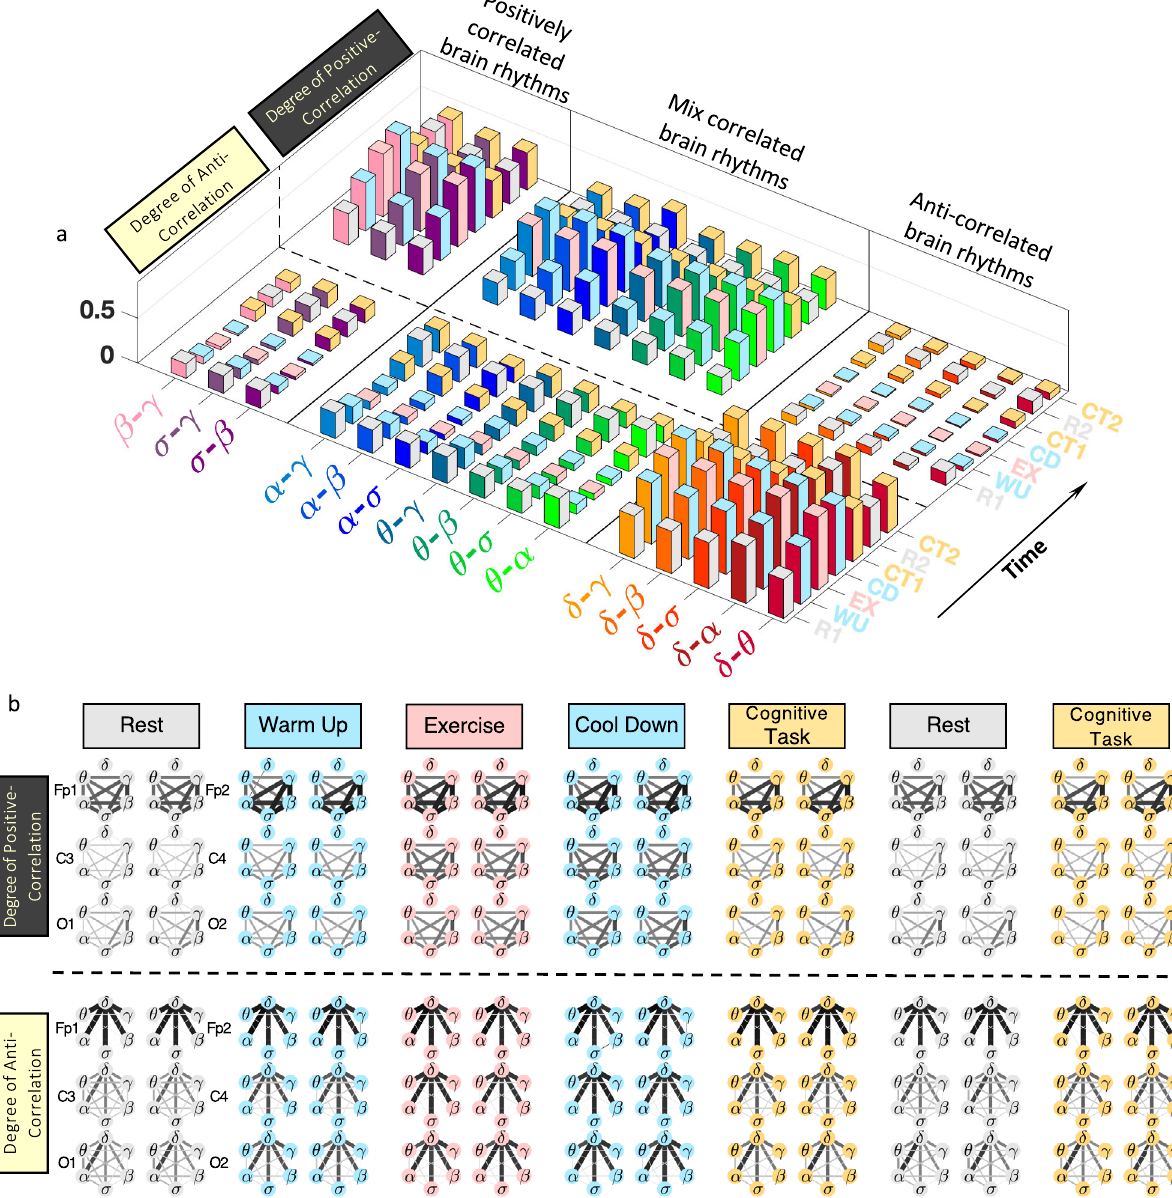
Fig. 5 Network communications and topological clustering of brain-rhythm interactions at different cortical locations uniquely represent physiological states. a Three-dimensional representation of the degree of positive and anti-correlated components of coupling (bars height shows coupling strength for positive ( D + ) and anti-correlated ( D − ) coupling, Methods) for the three major classes of brain-rhythm interactions (positively correlated, mix correlated and anti-correlated pairs of brain rhythms; Fig. 2), and their evolution in time (Experimental protocol, Methods) across physiological states. The panel shows coupling for all pairs of brain rhythms at the C3 EEG channel location and provides a complete picture of the response in brain-rhythm interactions to changes in physiological states. b Networks representing brain-rhythm interactions at six cortical locations (Fp1, Fp2, C3, C4, O1, O2) for the left- and the right-brain hemispheres during different physiological states. Sub-networks of positive (top panel) and anti-correlated (bottom panel) components of brain rhythms coupling exhibit variations in topology and links strength organization depending on cortical locations and physiological states. Line thickness and darkness are scaled linearly to link strength. A clear symmetry in network structure is observed between the left (Fp1, C3, O1) and the right (Fp2, C4, O2) hemisphere for each physiological state. Sub-networks representing brain-wave interactions at the frontal areas are characterized by stronger links compared to the central and occipital areas, a behavior more pronounced at rest and cognitive tasks. Notably, despite their differences, networks at each cortical location undergo the same pattern of reorganization in topology and link strength across physiological states, indicating a global mechanism regulating brain-rhythm interactions at different cortical Our investigations demonstrate that despite the diversity in interactions with different coupling forms for different states brain-rhythm interaction patterns, all coupling forms fall in three (Fig. 2). The collective behavior of brain rhythms is represented major classes, where some pairs of rhythms maintain the same by an entire ensemble of coupling pro fi les that is consistent for all form of positive and anti-correlated coupling during all states, healthy subjects and uniquely de fi nes each physiological state while other pairs are characterized by mixed-correlated (Fig. 2). This ensemble of pro fi les captures the dynamics of